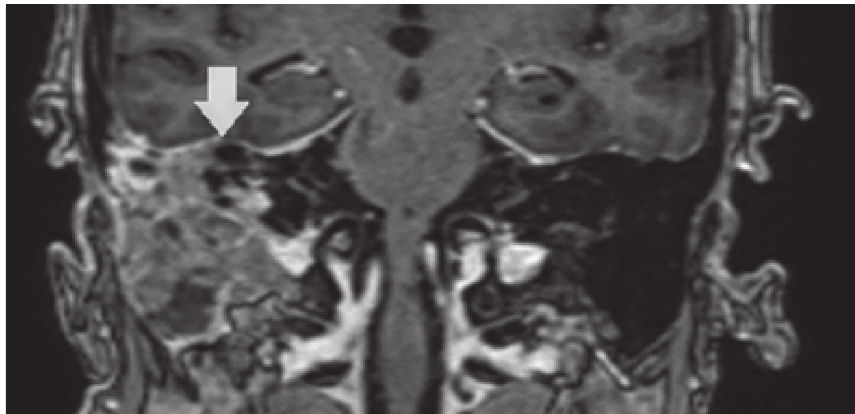
Figure 3: Initial coronal MRI demonstrating a heterogenous tissue mass in the right middle ear mastoid up to the dura of the middle cranial dura (white arrow).